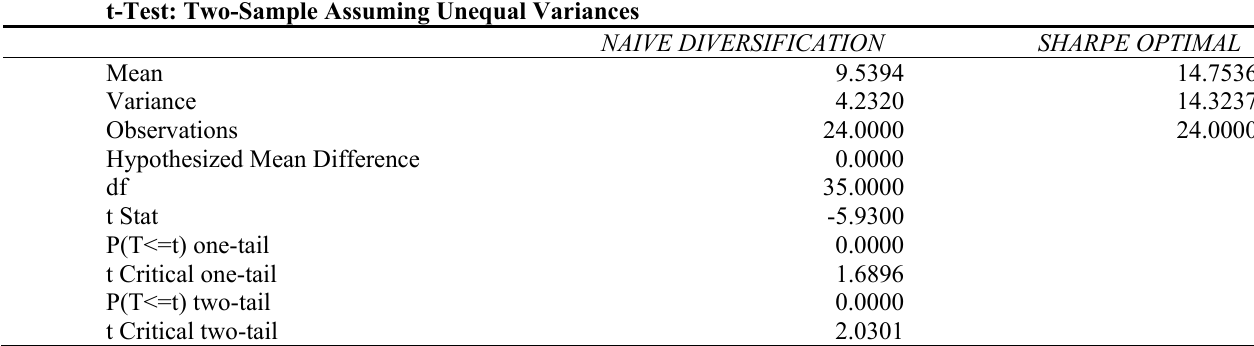
Hypothesis Testing among Bottom Rating Portfolio t-Test: Two-Sample Assuming Unequal Variances